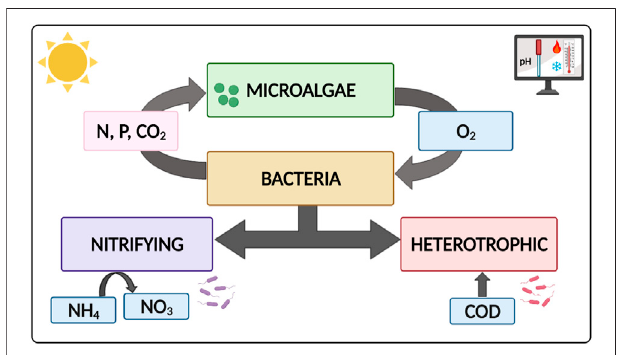
FIGURE 1 | Overall scheme of microalgae-bacteria interaction in wastewater treatment